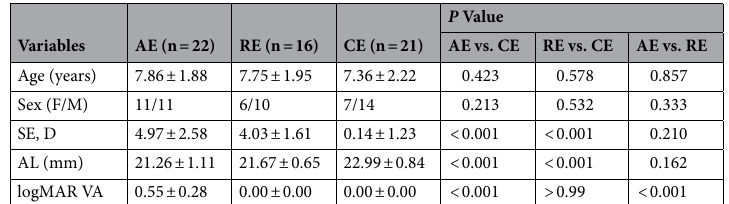
Table 1. Patient demographics and refractive status. Unpaired t test was used for analysis of continuous variables, χ 2 test was employed for analysis of categorical variables, data shown as mean ± SD. AE amblyopia eyes, RE recovered amblyopia eyes, CE control eyes, SE spherical equivalents, AL axial length, F female, M male, D diopter, NA not applicable, SD standard deviation.